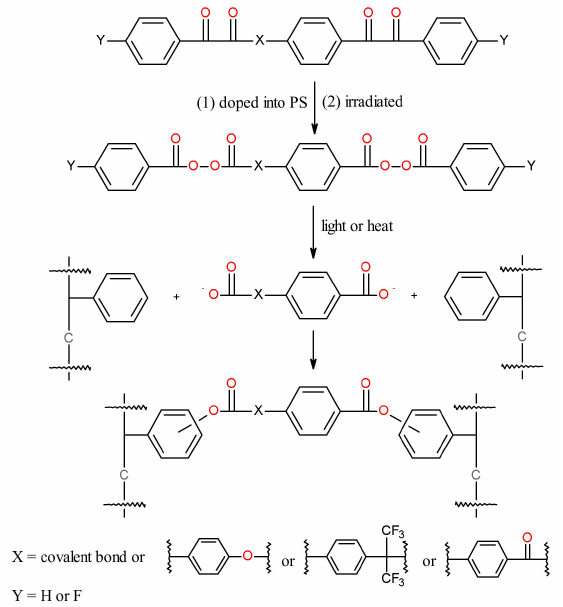
Scheme 7. Photoperoxidation and decomposition of a low-molecular-weight dopant containing two 1,2-dicarbonyl groups for crosslinking chains of PS in films.